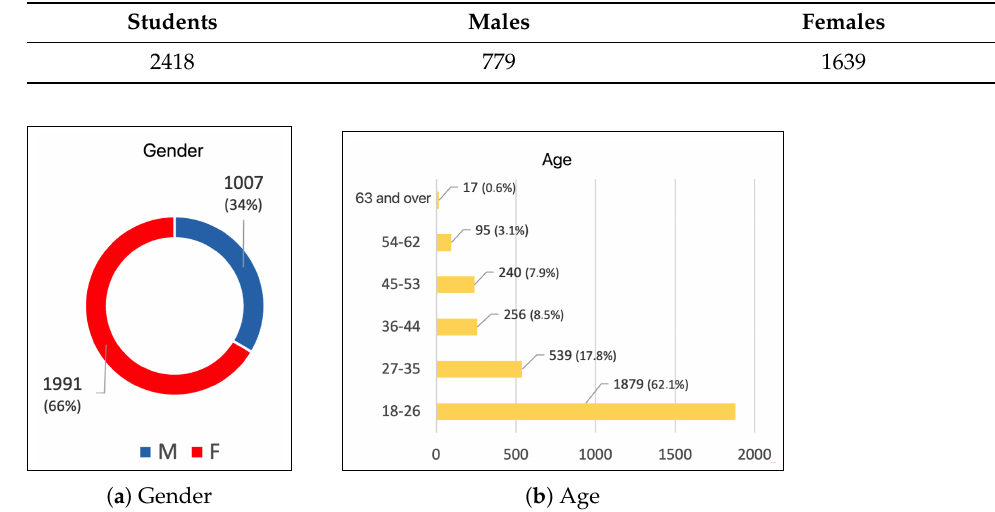
Figure 7. Gender and age of respondents.